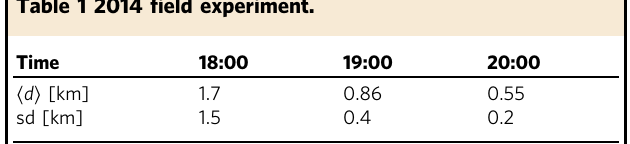
Table 1 2014 fi eld